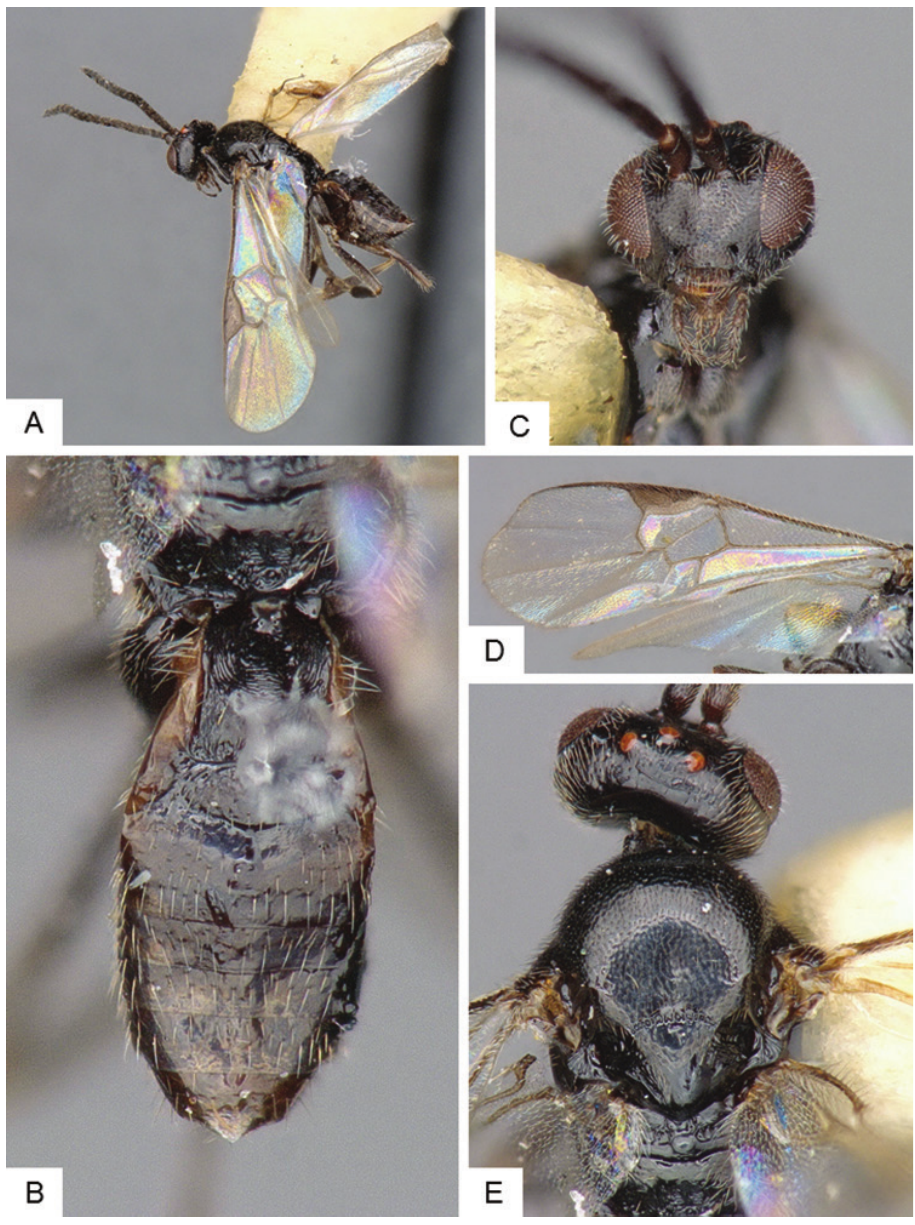
Figure 10. Dolichogenidea sp. 2. A Habitus, lateral B Metasoma, dorsal C Head, frontal D Fore wing E Head and mesosoma (partially),